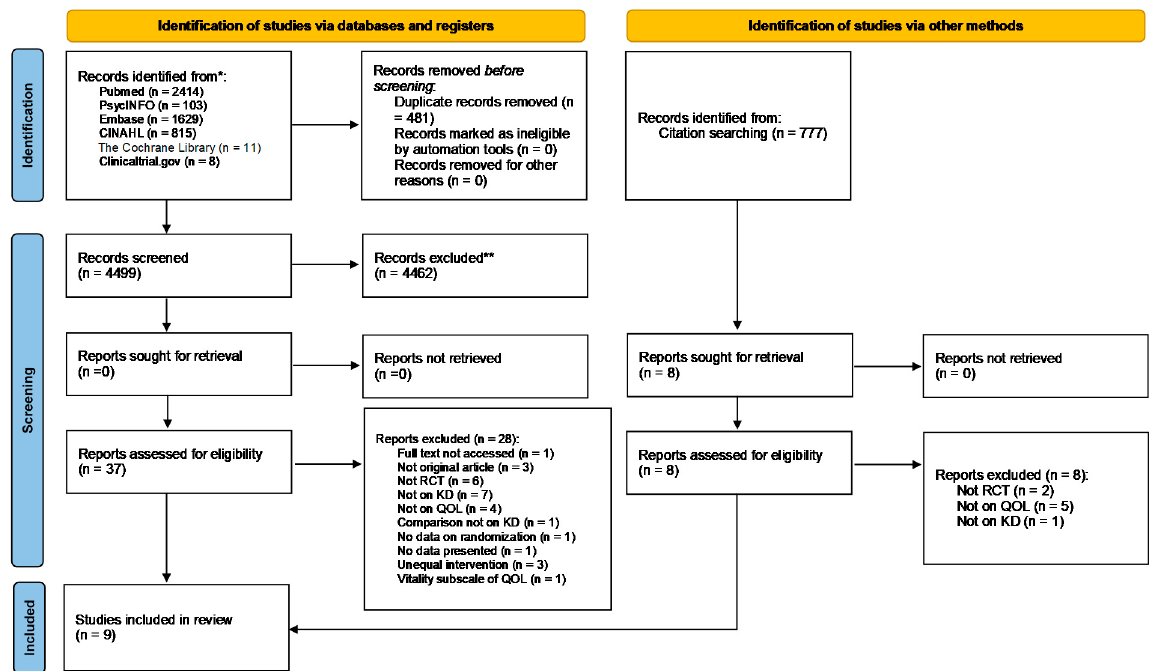
Figure 1. Preferred Reporting Items for Systematic Reviews and Meta-Analyses (PRISMA) diagram of study selection. CINAHL: Cumulative Index to Nursing and Allied Health Literature; RCT: Randomized Controlled Trial; KD: Ketogenic Diet; QOL: Quality of Life.